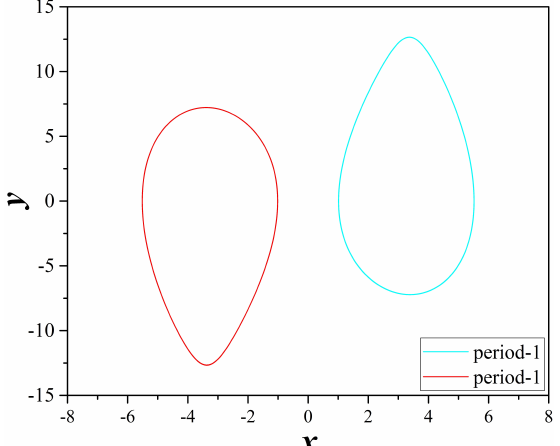
Figure 13. Coexisting attractors of system (2), for a = 4 × 10 − 4 , b = 1, c = 3.846 × 10 − 4 , e = 1 and d = 19. With cyan color and for ( x 0 , y 0 , z 0 ) = ( 0,0.1,0 ) a period-1 attractor, while with red color and ( x ) = ( − 5.5160634,0,1.737452 ) a symmetric period-1 attractor. 0 , y 0 , z 0